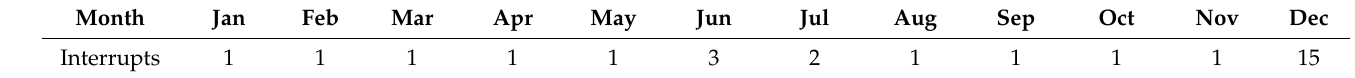
Table 3. The number of system interruptions for maintenance.